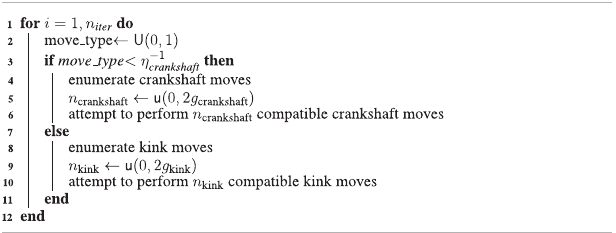
Algorithm 2 | SAP-Move